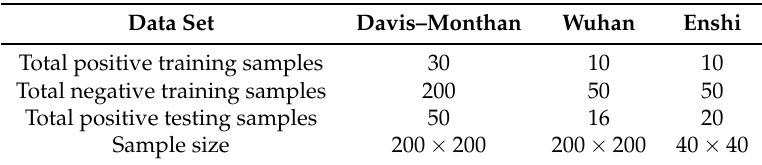
Table 3. The training and testing samples in three experimental data